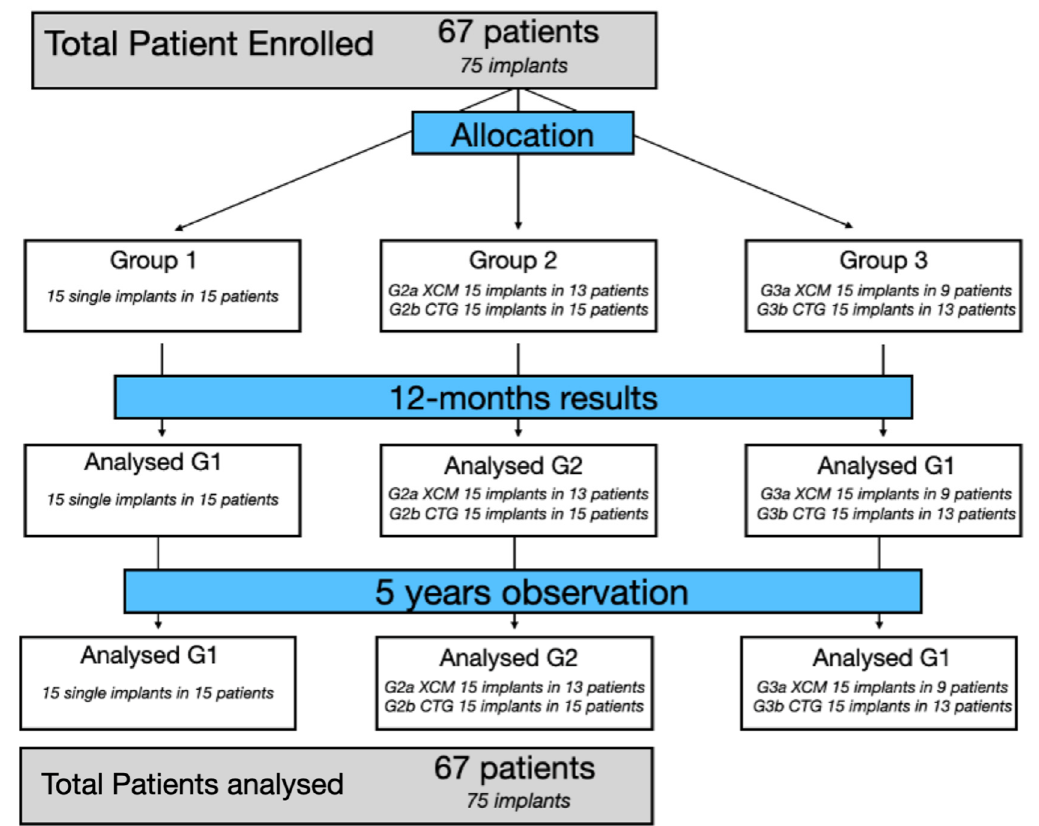
Figure 1. Flow chart, study schedule and timeline. G1—No gingival augmentation. Fifteen single implants in fifteen